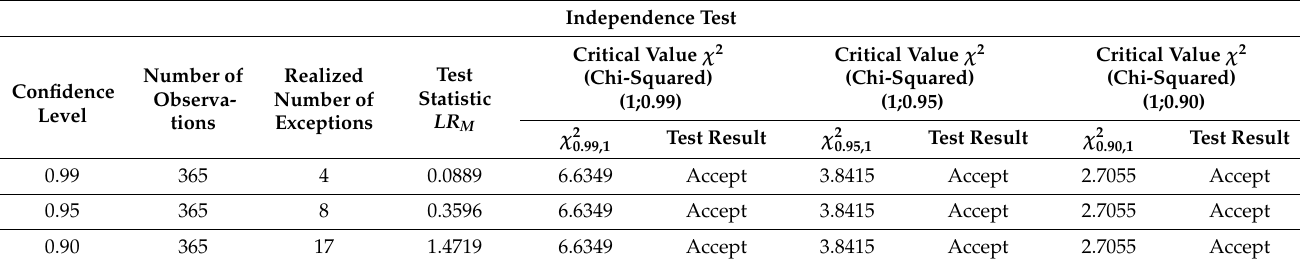
Table 12. Monte Carlo simulation VaR Independence Test.